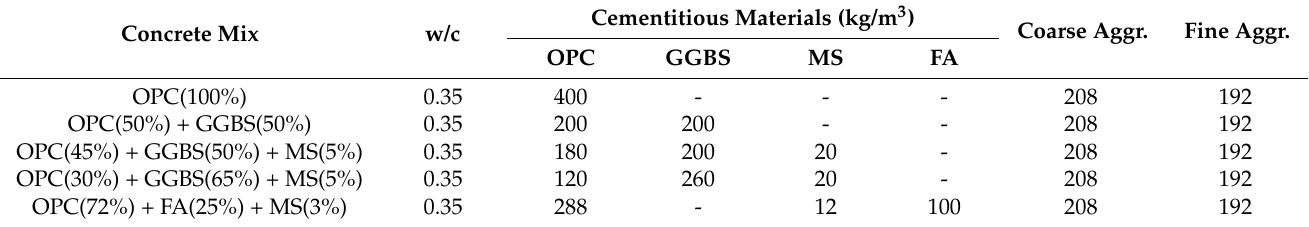
Table 3. Composition of concrete mixes used for experimental investigation.